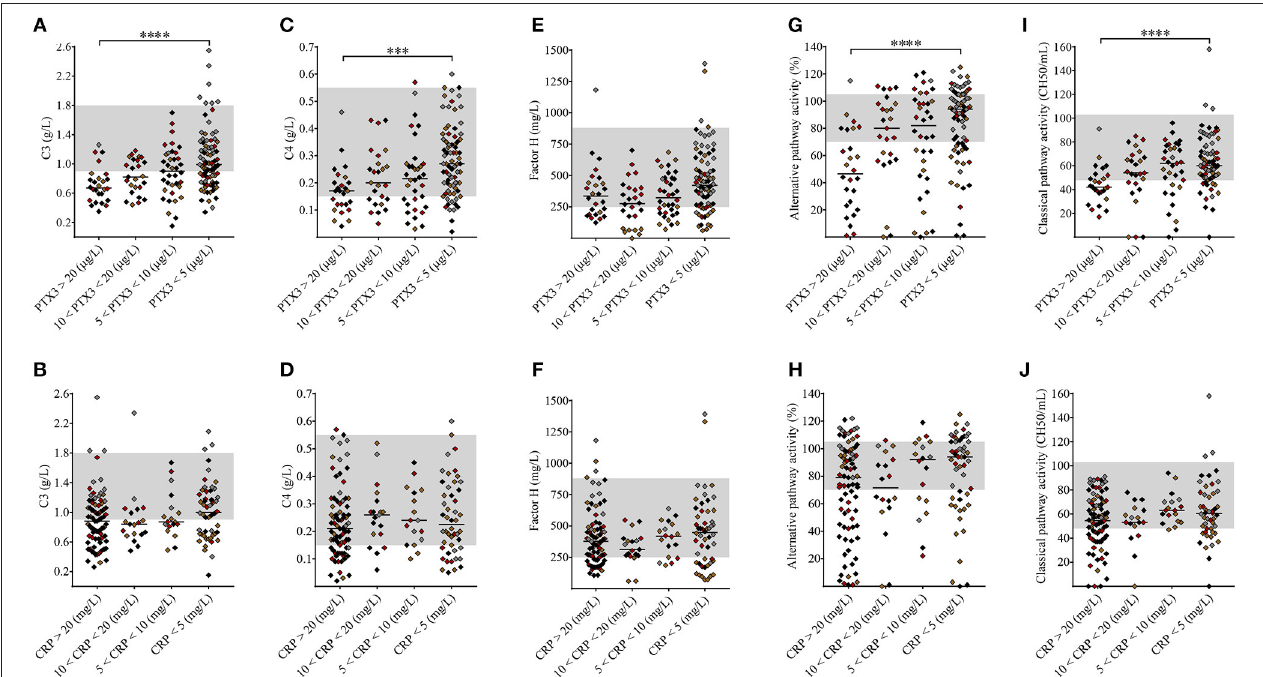
FIGURE 5 | Association of the systemic pentraxin levels with laboratory signs of complement consumption. The degree of complement activation and consumption was assessed from complement factor levels ( A–F : C3, C4, FH) and complement activity parameters (G–J) in TMA patients subdivided based on the measured systemic PTX3 or CRP levels, respectively. Data are expressed as mean of technical duplicates, the horizontal lines show the median of each group and the laboratory normal range is indicated with gray shading. The color of each data point indicates the specific form of TMA corresponding to Figure 1 (brown, aHUS; red, STEC-HUS; black, secondary TMA; gray, TTP). Statistical analysis was performed with the Kruskal-Wallis test corrected for multiple comparisons using the Dunn’s post hoc test. ANOVA p < 0.0001 , p = 0.1285, p = 0.0002 , p = 0.6713, p = 0.0358 , p = 0.2173, p < 0.0001 , p = 0.0717, p = 0.0001 , p = 0.053 for (A–J) , statistical significance of the Dunn’s tests are indicated by asterisks (*** p < 0.001, **** p < 0.0001) on the respective figure panels (A–J) . aHUS, atypical hemolytic uremic syndrome; CRP, C-reactive protein; PTX3, pentraxin-3; STEC-HUS, Shiga-like toxin associated HUS; TMA, thrombotic microangiopathy; TTP, thrombotic thrombocytopenic purpura.